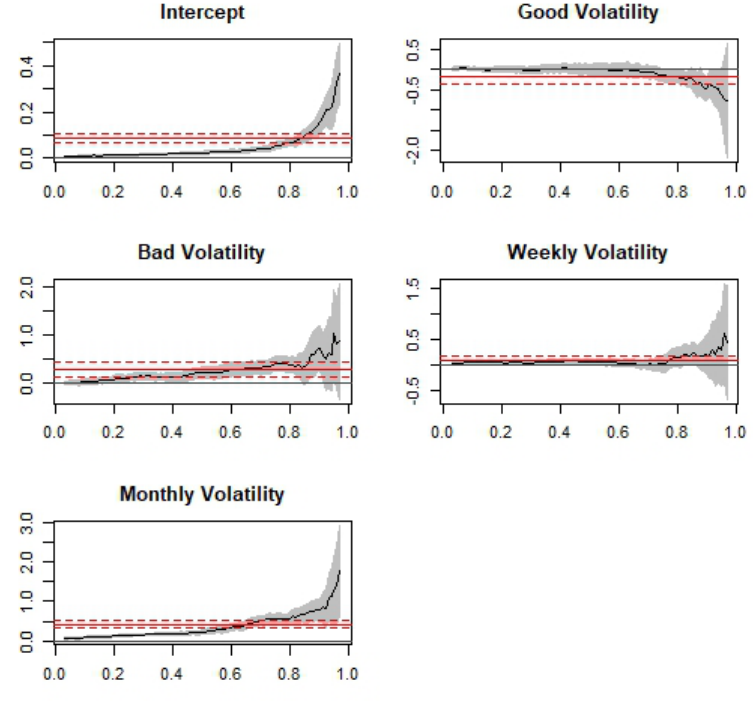
Figure 3. Model 2: HAR-RV-QR results—7-day